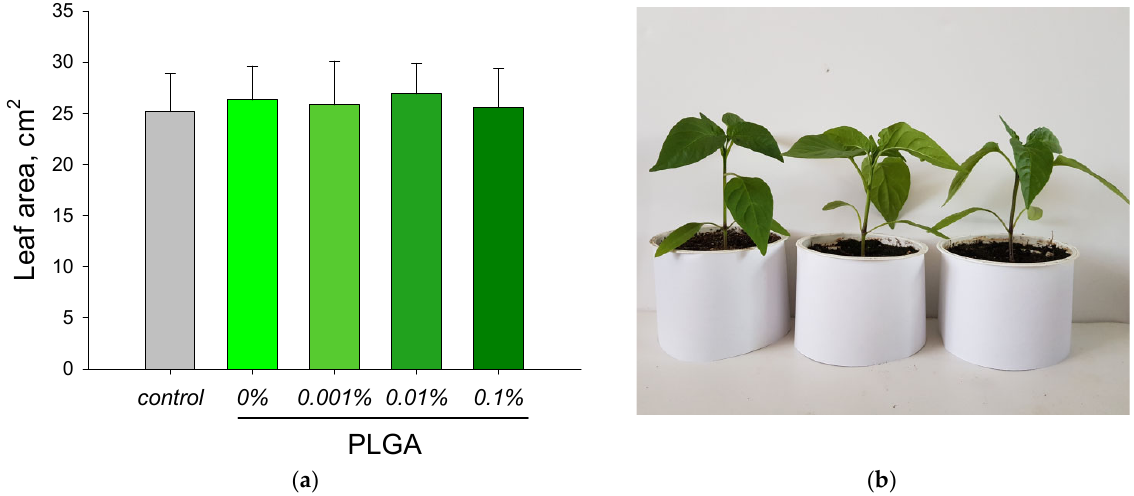
Figure 9. Influence of a nanocomposite based on PLGA and iron oxide nanoparticles on the leaf size of Capsicum annuum pepper plants ( a ). Data are presented as mean values and standard errors of the mean. On the right is a comparative photograph of random plants from groups (1) Control, (2) PLGA without nanoparticles and (3) PLGA with 0.1% iron oxide nanoparticles ( b ).